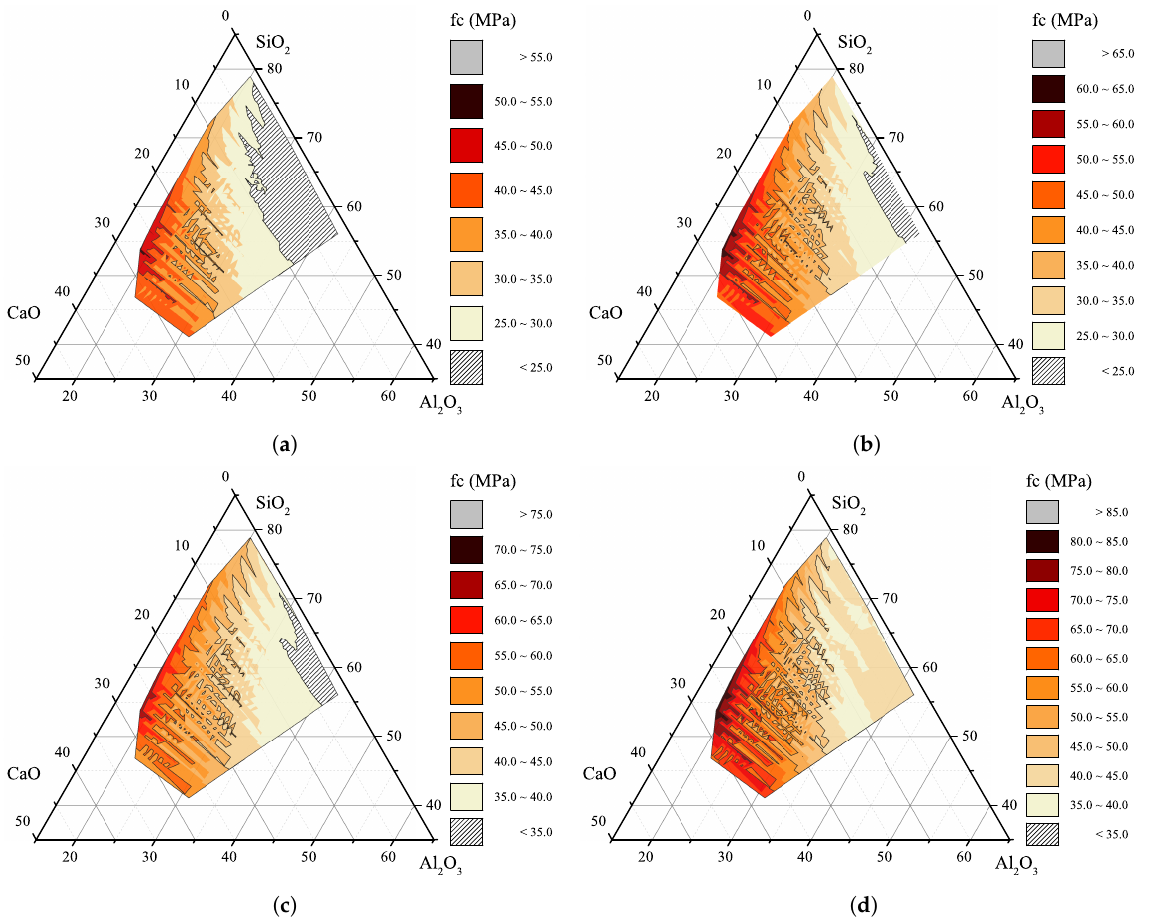
Figure 9. Effect of various combination of chemical composition of SCM on the compressive strength of concrete at ( a ) 28-days, ( b ) 56-days, ( c ) 90-days, and ( d )